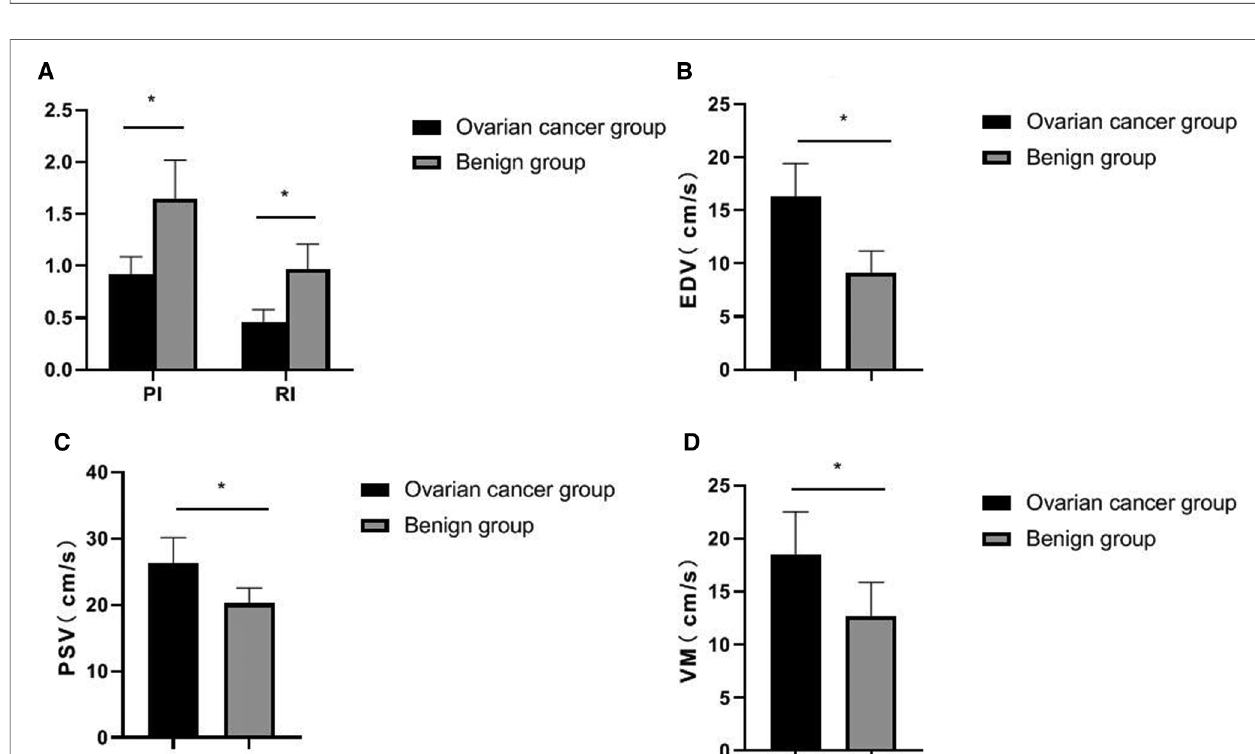
FIGURE 1 | Pathological types of patients in two groups. ( A ) benign ovarian tumors; ( B ) malignant ovarian tumors.